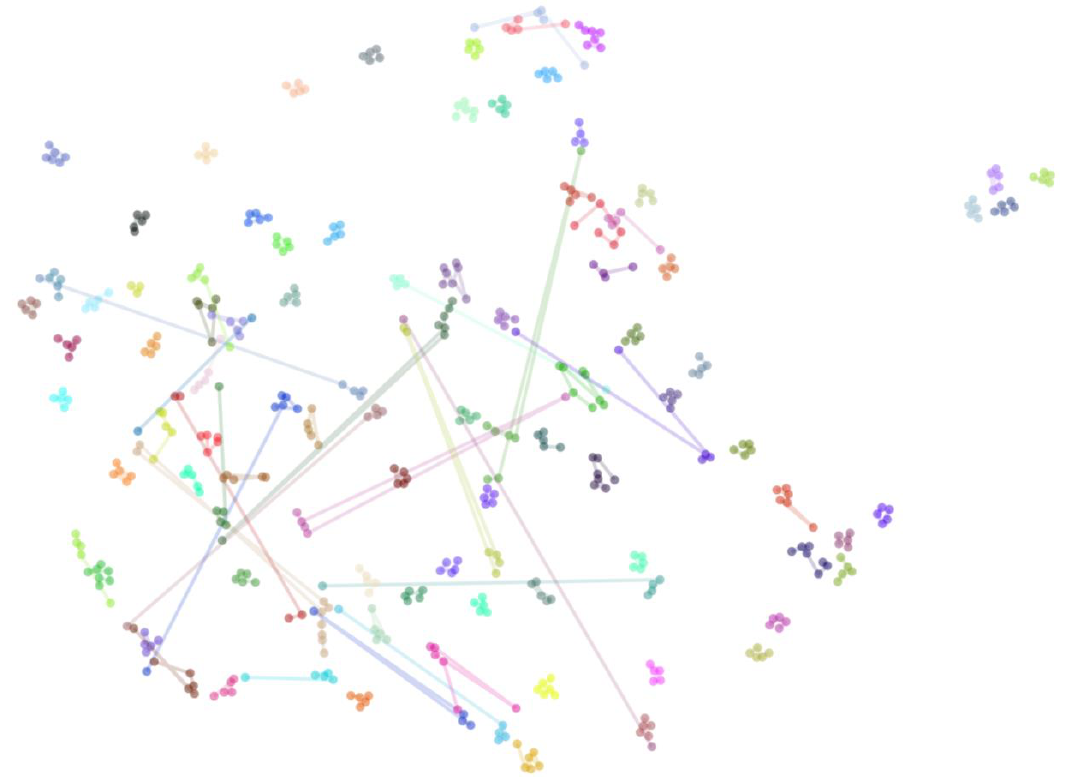
Figure 11. t-Distributed Stochastic Neighbor Embedding (t-SNE) visualization of a subset of the validation set containing 100 clients. Each signature is represented as a color dot. Signatures belonging to a single person are connected with a line.